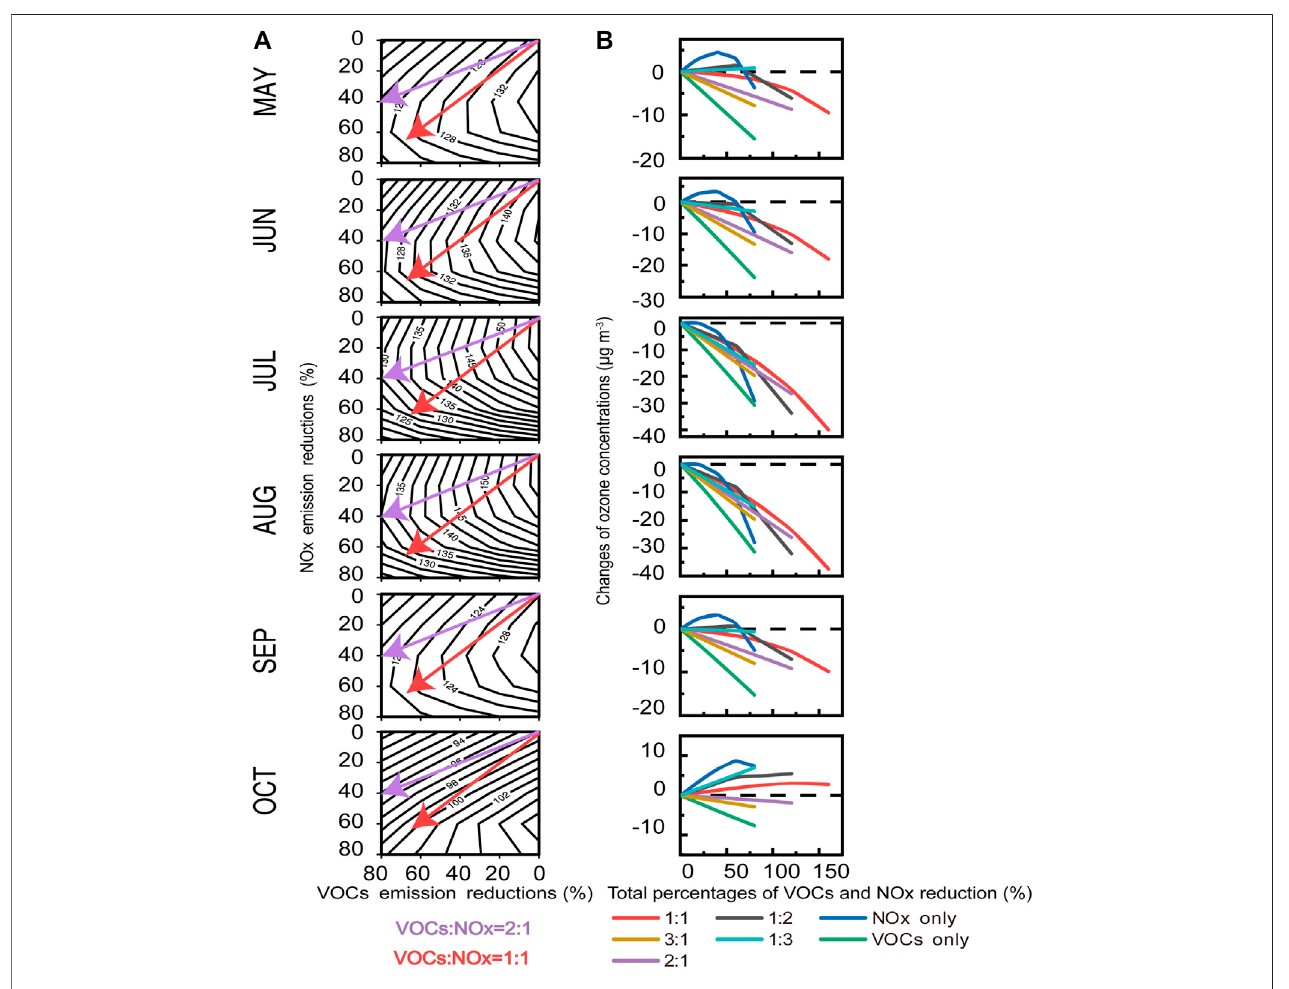
FIGURE 5 | Same as Figure 4 , but for